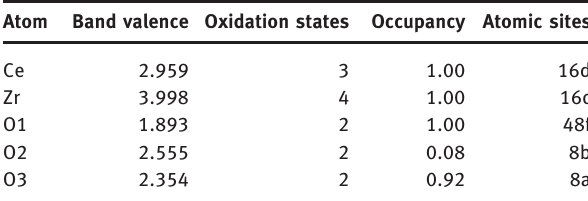
Table 6: Summary of results for unit cell refinements [22].